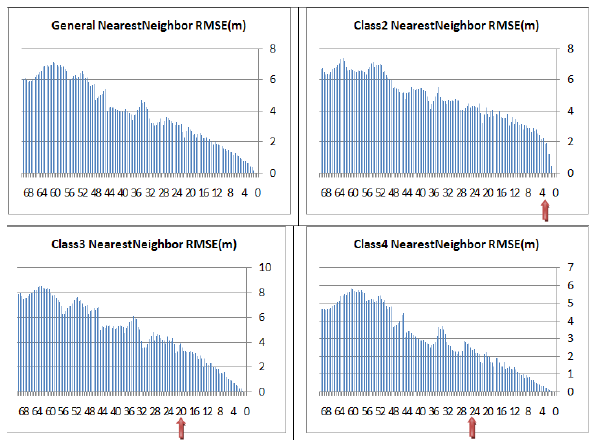
Table2. Bilinear interpolation precision at each of classes with increasing step of a pixel